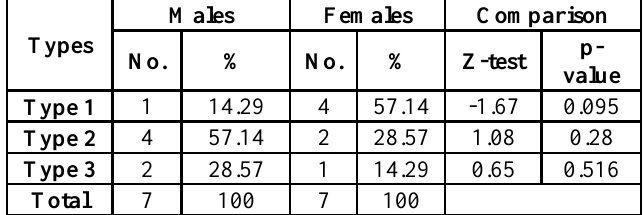
Table 5: Distribution according to canal